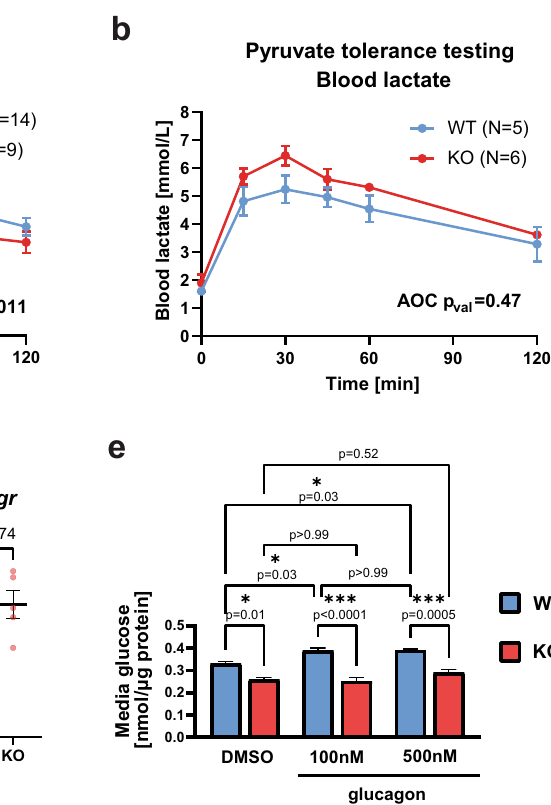
Fig.4| Gpr151 regulateshepaticgluconeogenesisinacell-autonomousmanner. a Blood glucose levels measured during pyruvate tolerance testing (PTT) in male DIO WT and KO mice. AOC compared using two-tailed Student ’ s t test ( N =14, WT; N =9, KO). b Blood lactate levels during PTT in male DIO WT and KO mice. AOC comparedusingtwo-tailedStudent ’ s t test( N =5,WT; N =6,KO). c Quanti fi cationof glucagon levels in blood plasma of fasted 16-week-old DIO mice by ELISA. Two- tailed Student ’ s t test ( N =6, WT; N =7, KO). d RT-qPCR quanti fi cation of glucagon